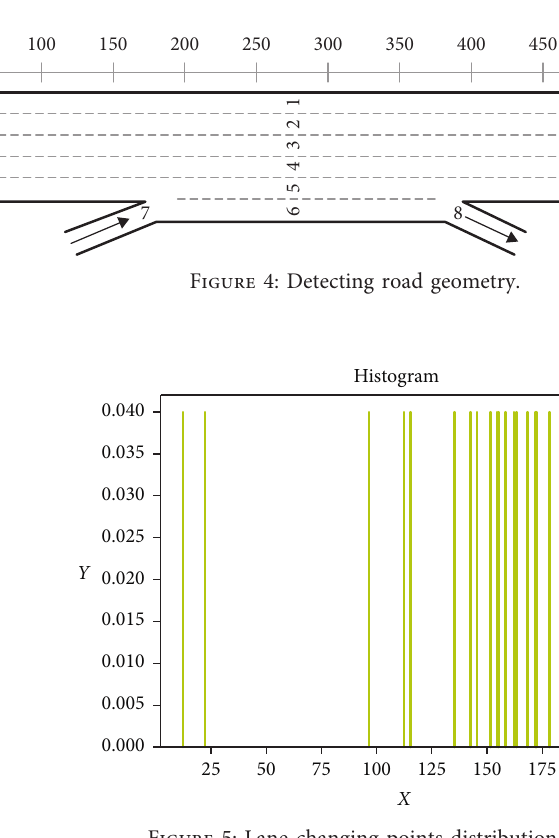
Figure 5: Lane-changing points distribution.